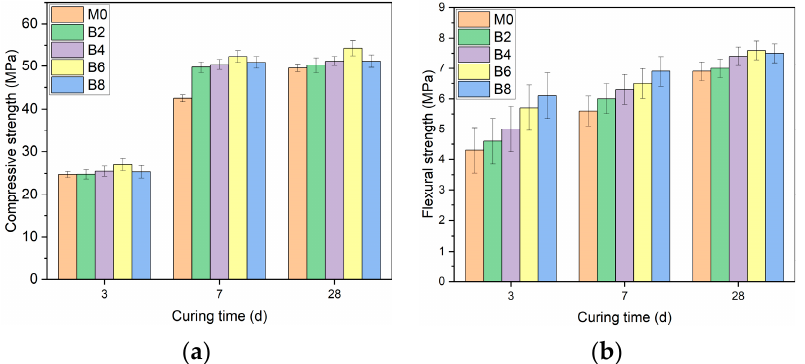
Figure 5. The e ff ect of borax on the compressive and fl exural strength of AAS with di ff erent borax dosages. ( a ) Uncon fi ned compressive strength; ( b ) fl exural strength. dosages. ( a ) Unconfined compressive strength; ( b ) flexural strength.